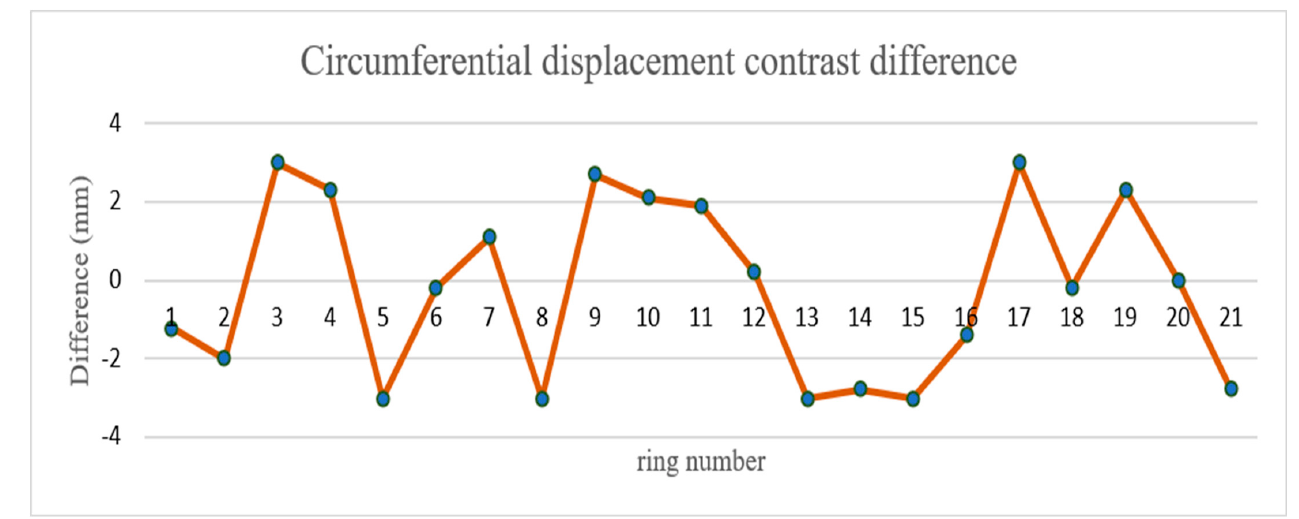
Figure 15. Circumferential displacement contrast difference.